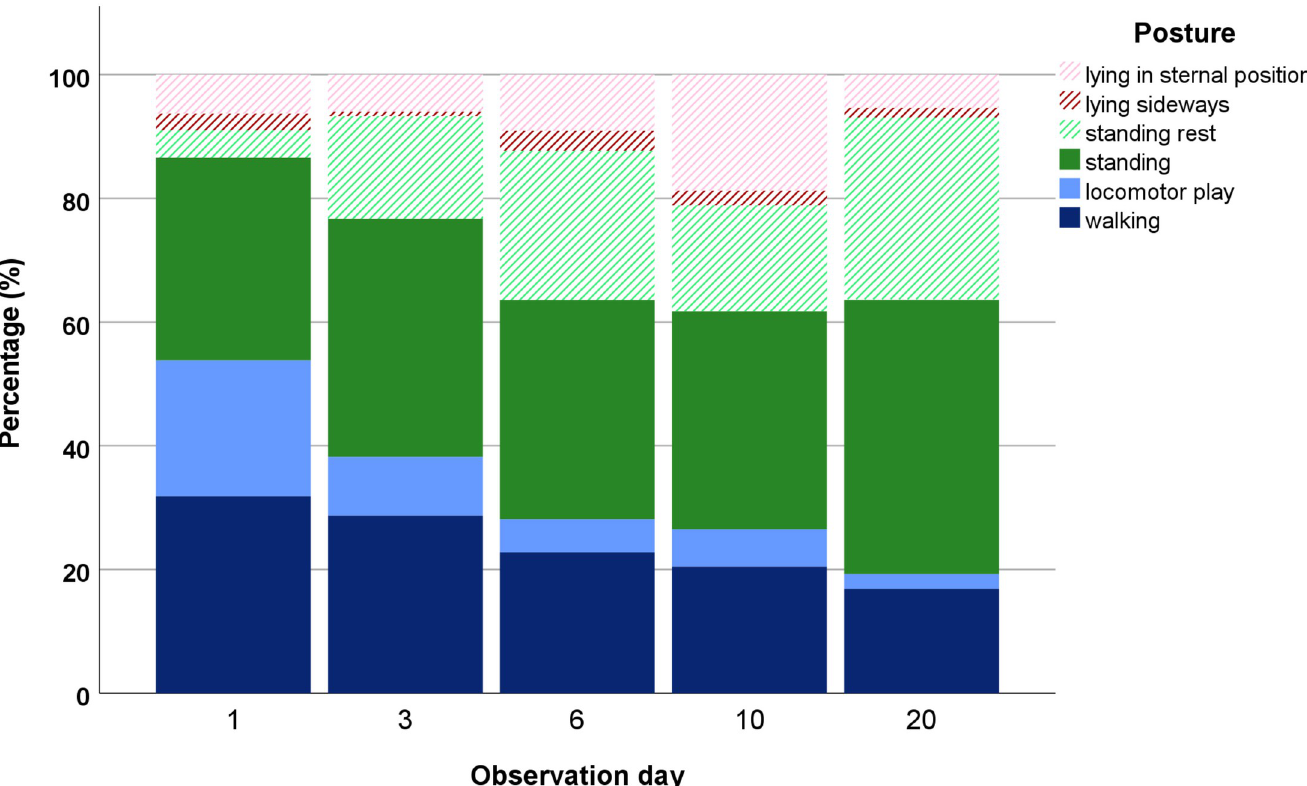
Fig 3. Posture development during the study. Differentiation of posture into lying (red), standing (green) and movement (blue). Note that observation day 1 is one day before weaning and observation day 3 one day after weaning.